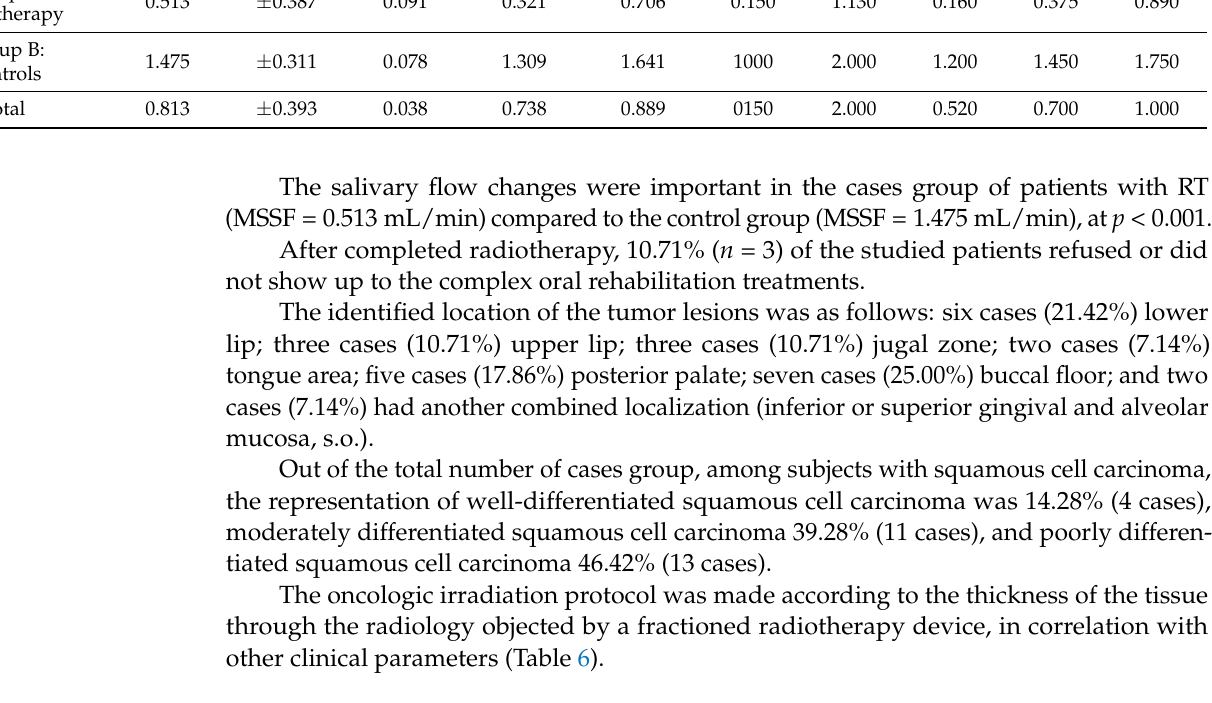
Table 6. Distribution of applied irradiation from the cases